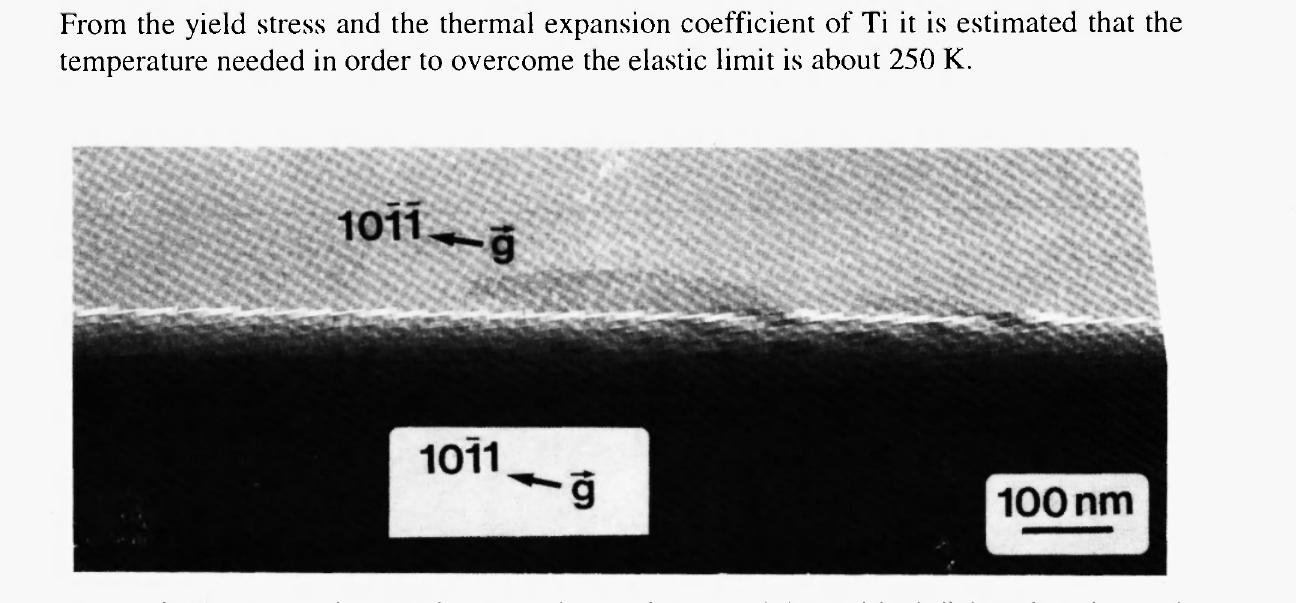
Figure 2. Computer simulated image of an extinction of the residual dislocations imaged with the 1011 /1011 common in the two crystals A B